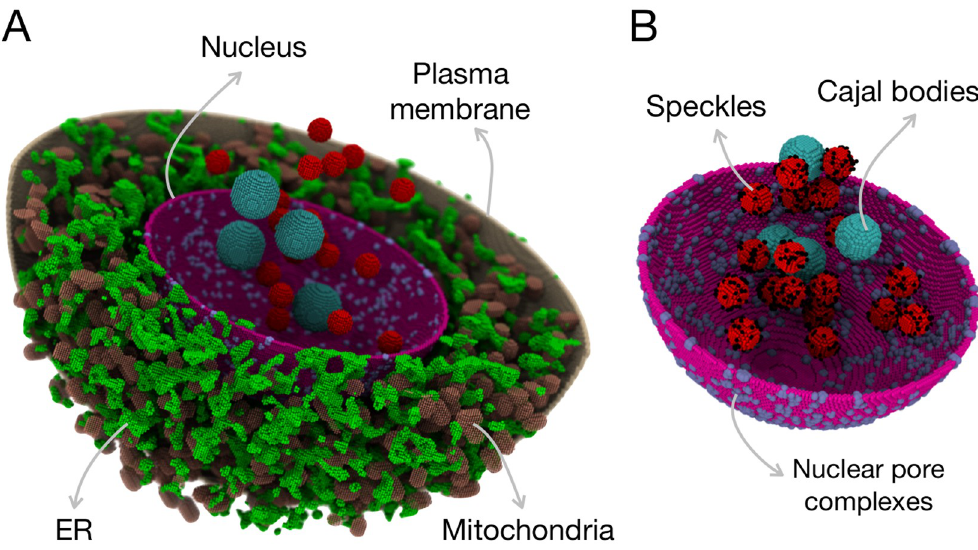
Fig 1. A data-driven model for a 18- μm HeLa cell: A) the cytoplasmic components are: ER, mitochondria and Golgi (not included in the figure for clarity); and B) a nucleus containing nuclear pore complexes, Cajal bodies and nuclear speckles. The cytosol, nuclear pore complexes, nuclear speckles, and Cajal bodies are directly involved in RNA splicing processes, whereas ER, mitochondria and Golgi apparatus provide excluded volume effects.